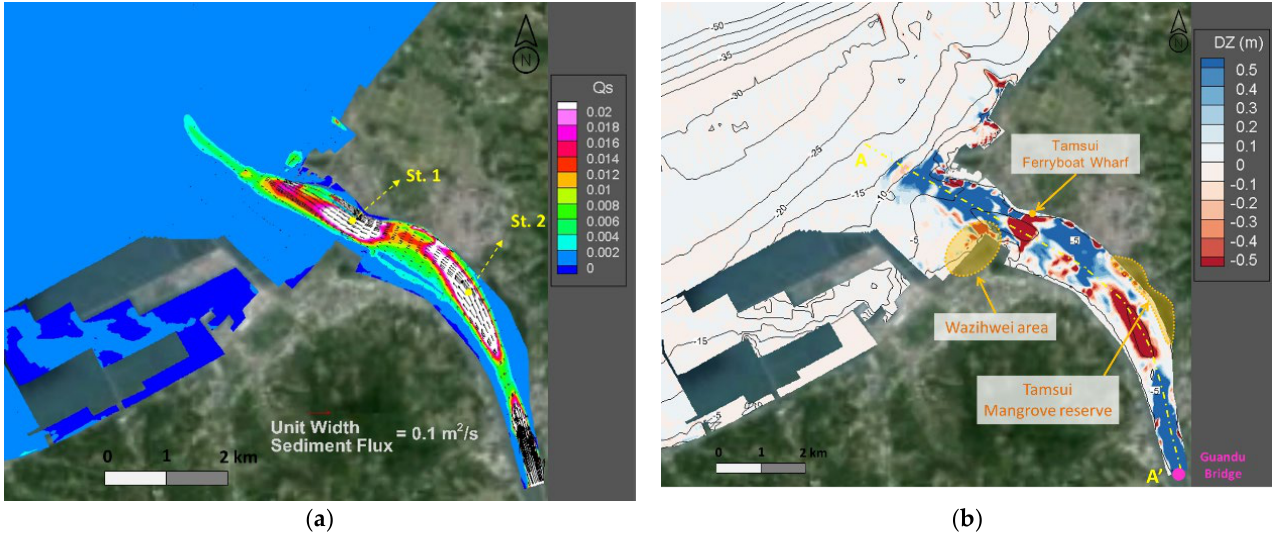
Figure 8. Sediment flux distribution and changes in bed scouring and deposition of Case 2 (DZ = bed change, the contour line is bed elevation. The unit is meters for both). ( a ) Distribution diagram of sediment flux at peak time. ( b ) Simulation results of bed scouring and deposition.